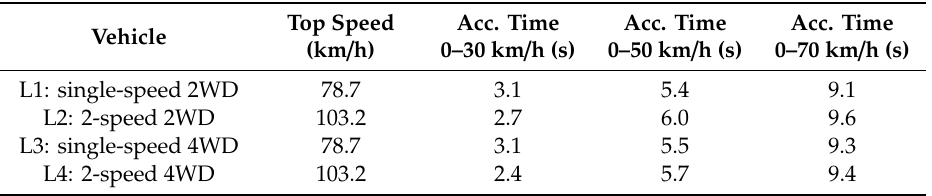
Table 4. Vehicle performance for the di ff erent